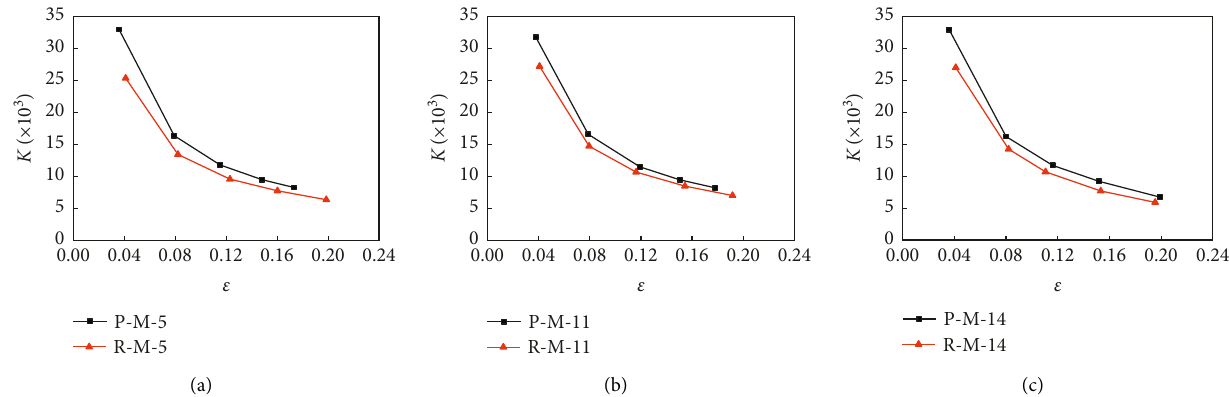
Figure 25: Secant stiffness of material specimens with different cross section shapes. (a) Standard material specimens. (b) Specimens under the loading pattern NM19. (c) Specimens under the loading pattern